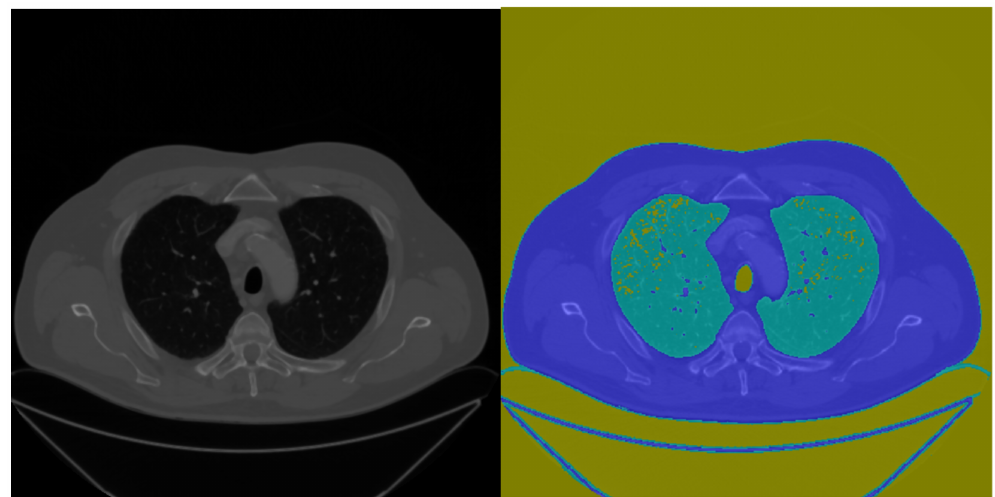
Figure 3. K-means initially segmented image.